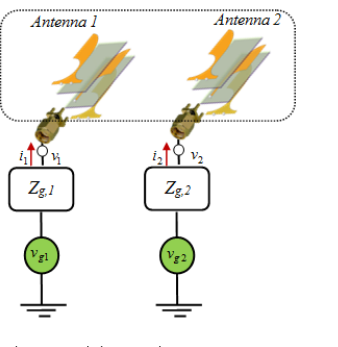
FIGURE 2. Coupling in transmitting